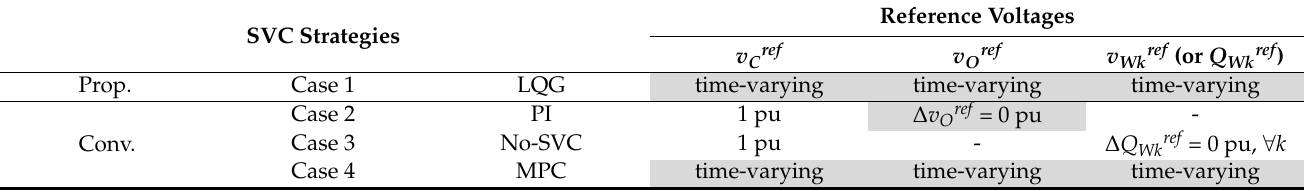
Table 5. Features of the proposed and conventional strategies.